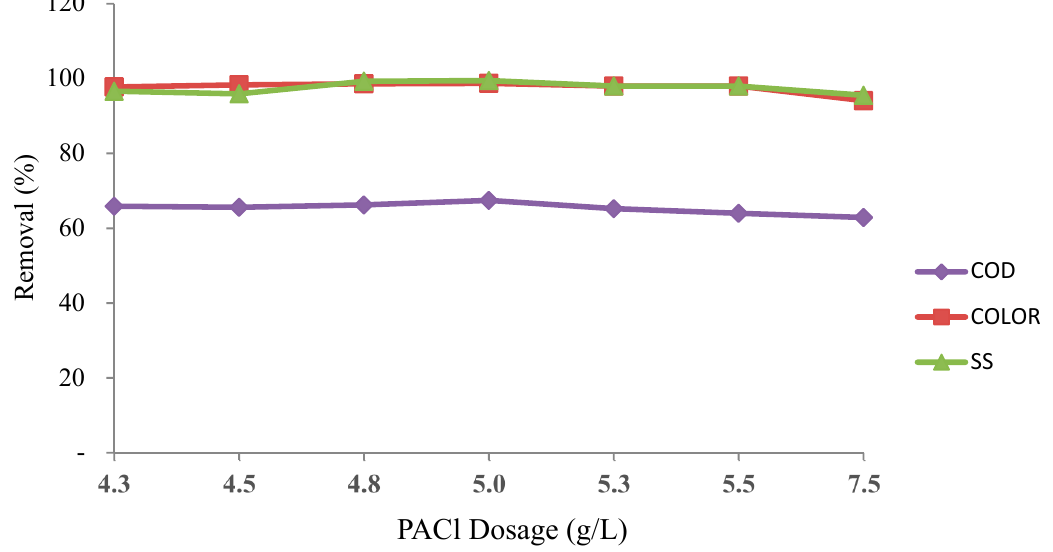
Figure 7. The effect of PACl major range of dosage on the removal of COD, color and SS at a constant pH 6.